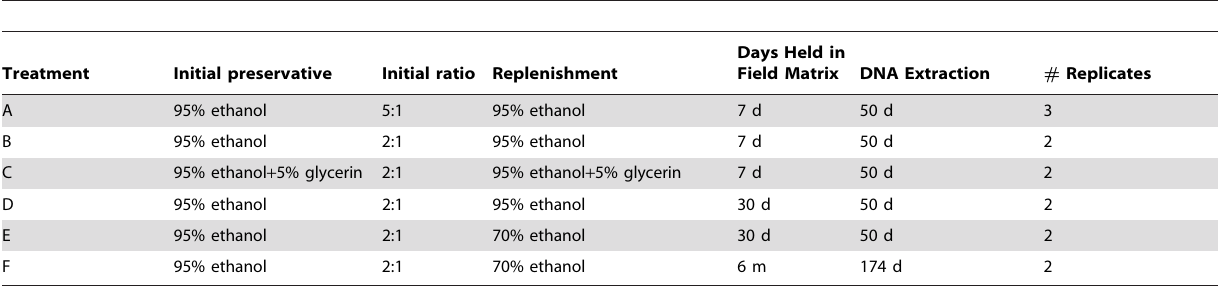
Table 1. Preservation treatments showing initial and replenishment concentrations of ethanol, days held in field matrix, day at which DNA extraction was performed, and number of replicates per treatment.